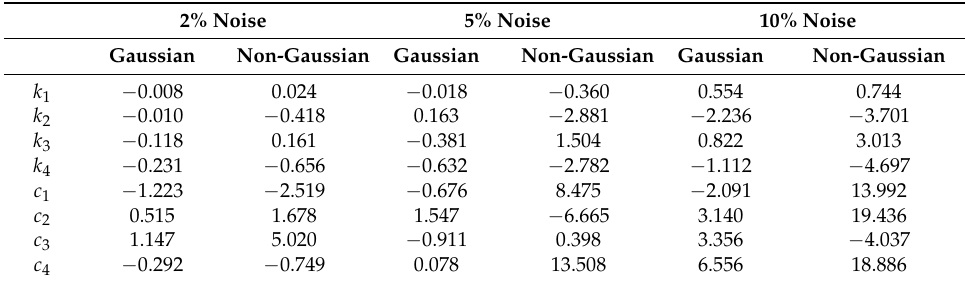
Table 1. Estimation errors of the identified results under Gaussian and non-Gaussian noise conditions.